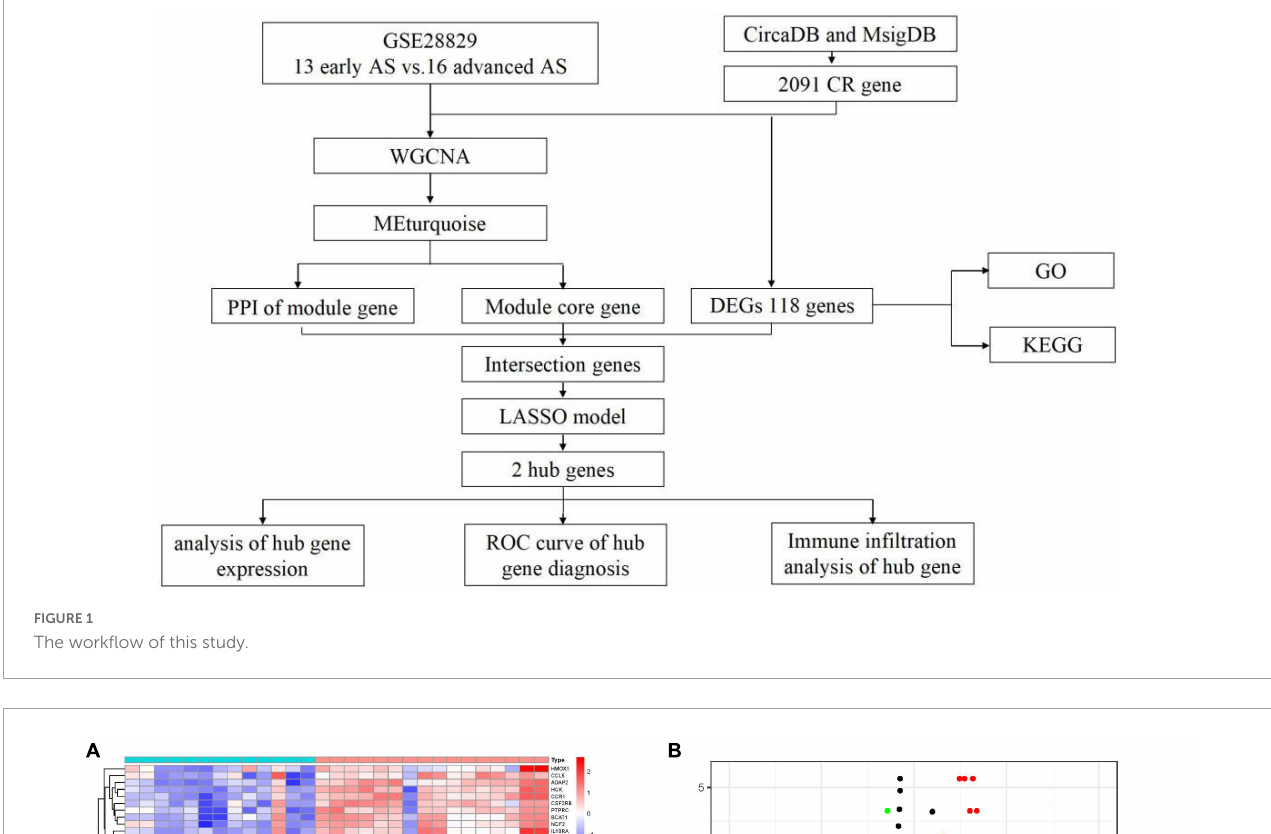
FIGURE1 The workflow of this study.